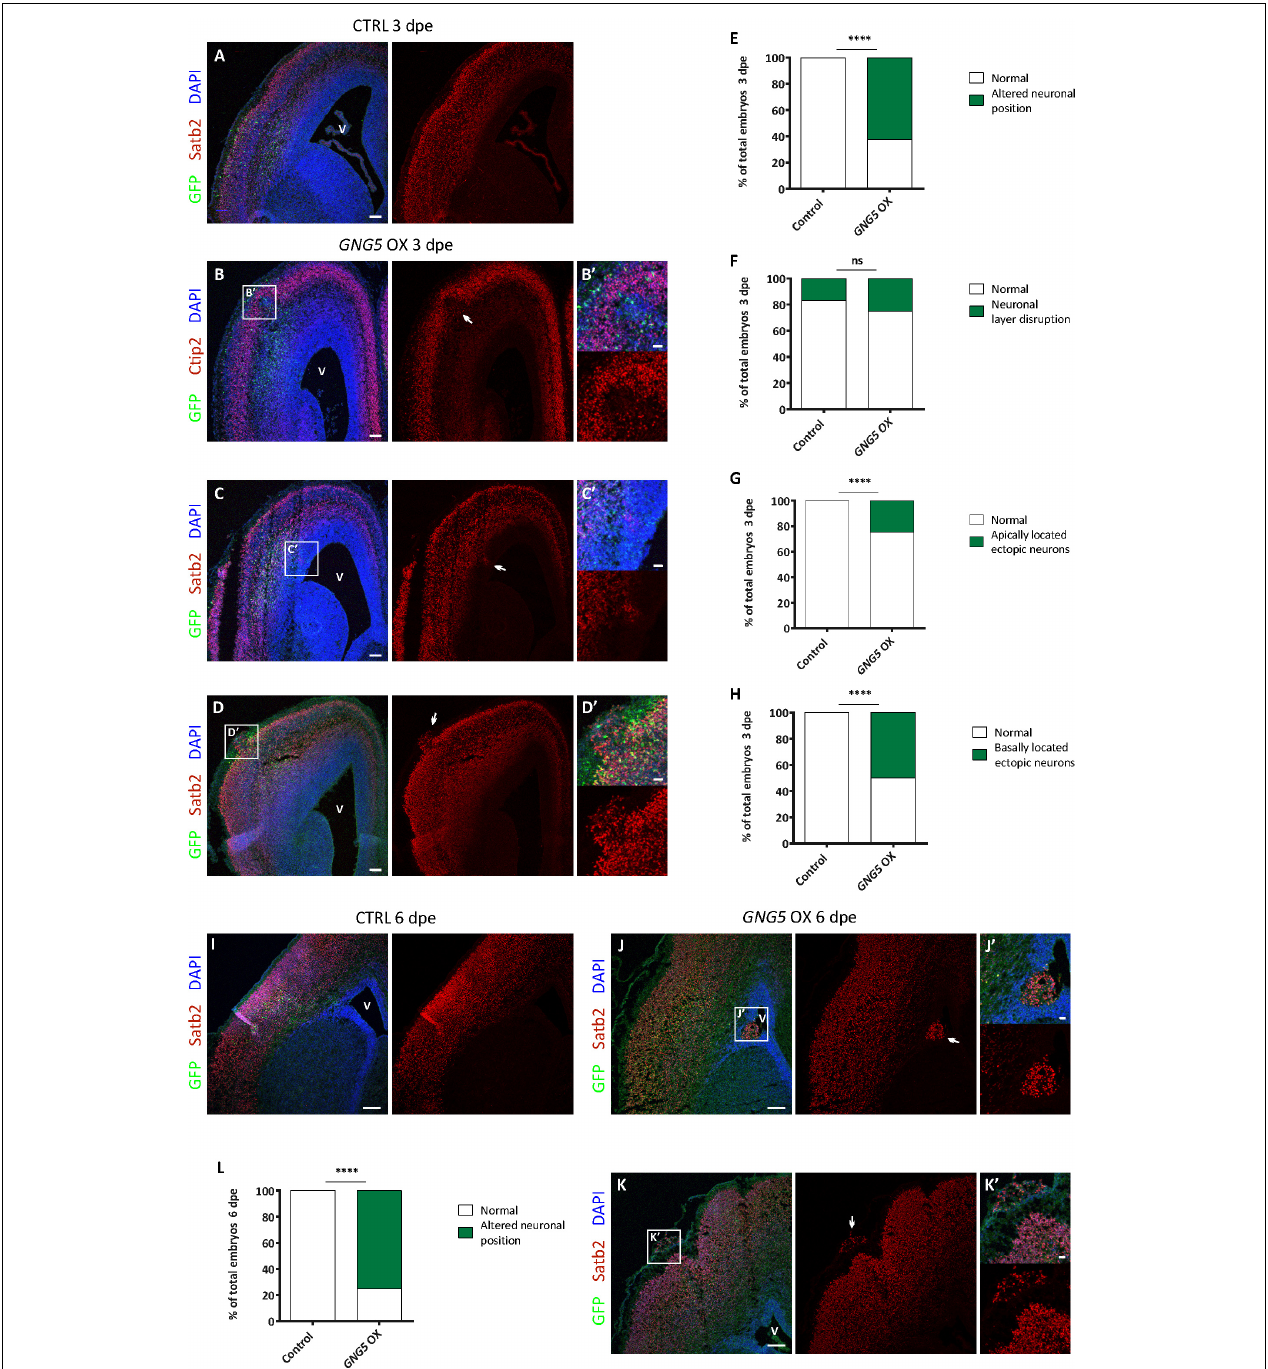
FIGURE 5 | Acute overexpression of GNG5 in E13 embryos induces migration defects in mice. ( A ) Representative images of a mouse section electroporated with a control plasmid at E13–E16 with an intact neuronal layer. (B–D (cid:48) ) Representative images of a brain section electroporated with the GNG5 plasmid and showing different neuronal migration defects: (B, B (cid:48) ) neuronal layer disruption, (C, C (cid:48) ) apically located ectopic neurons or (D,D (cid:48) ) basally located ectopic neurons. (E) Quantification of the percentage of embryos with any of the neuronal migration defects at 3 dpe or (F–H) specific neuronal defects: (F) neuronal layer disruption, (G) apically located ectopic neurons or (H) basally located ectopic neurons. (I) Representative images of a mouse section electroporated with a control plasmid at E13-E19 with an intact neuronal layer. (J–K (cid:48) ) Representative images of brain sections electroporated with the GNG5 plasmid and showing different neuronal migration defects: (J,J (cid:48) ) apically located ectopic neurons or (K,K (cid:48) ) basally located ectopic neurons. (L) Quantification of the percentage of embryos with neuronal migration defects at 6 dpe. Statistical analysis was based on exact binomial test ∗∗∗∗ p < 0.0001. Scale bar: (B (cid:48) –D (cid:48) ,J (cid:48) , K (cid:48) ) 30 µ m, (A–D) 100 µ m and ( I–K) 150 µ m. E13–E16 Control n = 6 and GNG5 OX n = 8. E13–E19 Control n = 3 and GNG5 OX n = 8. Abbreviations: CTRL, control; OX, overexpression; V,